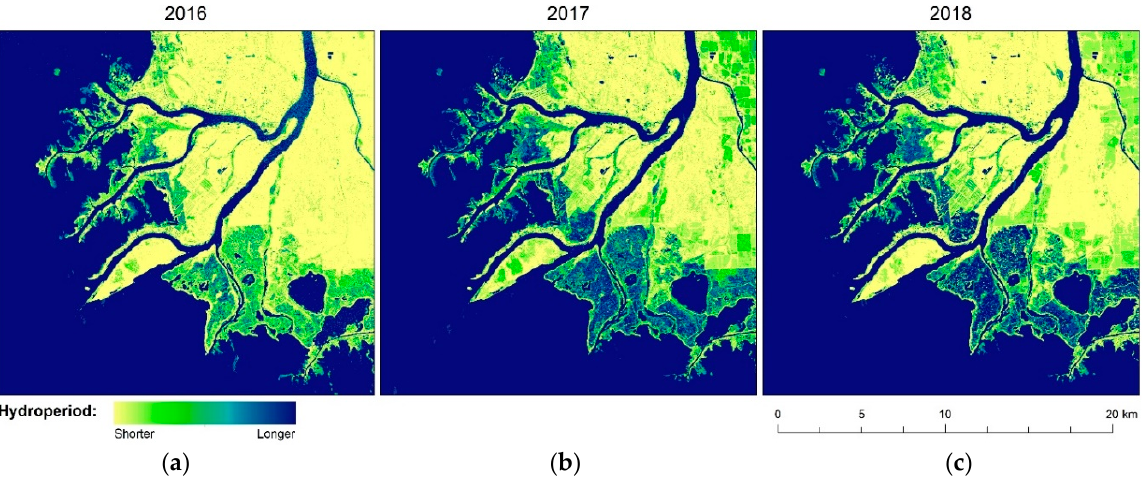
Figure 3. Relative hydroperiod maps of the St. Clair River Delta for ( a ) 2016, ( b ) 2017, and ( c ) 2018.